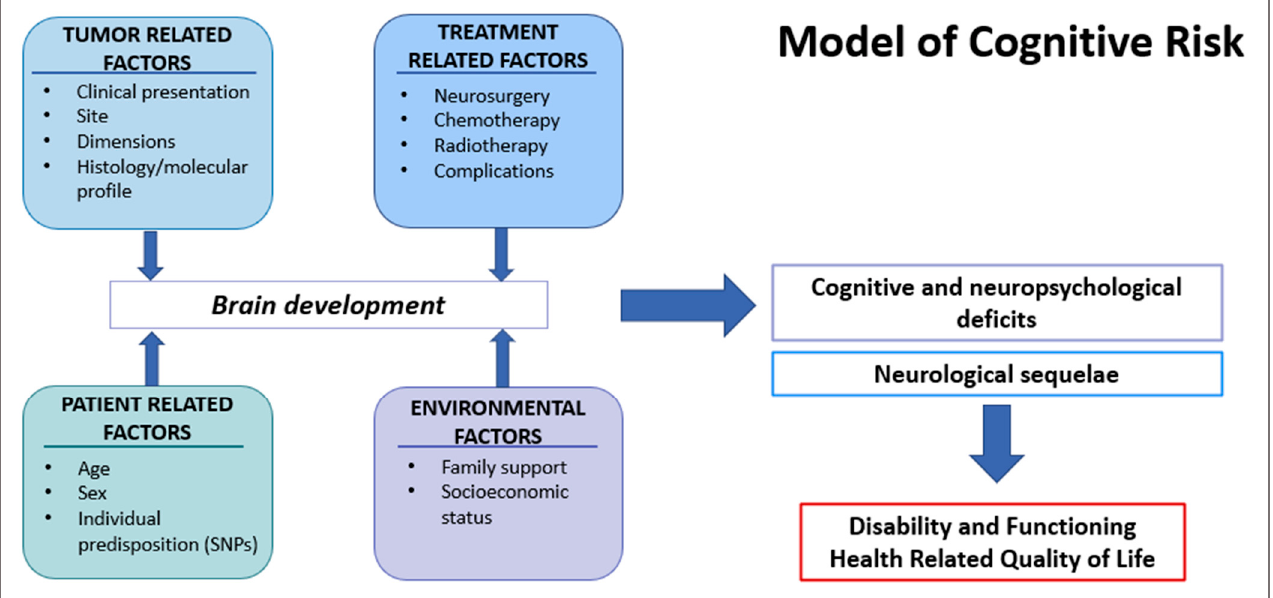
Figure 3. Interaction of multiple factors representing potential injury to the developing brain and leading to neurologic and cognitive/neuropsychological deficits. Ultimately, these late effects together are associated with disability in everyday activities and, therefore, with impaired Health-Related Quality of Life.